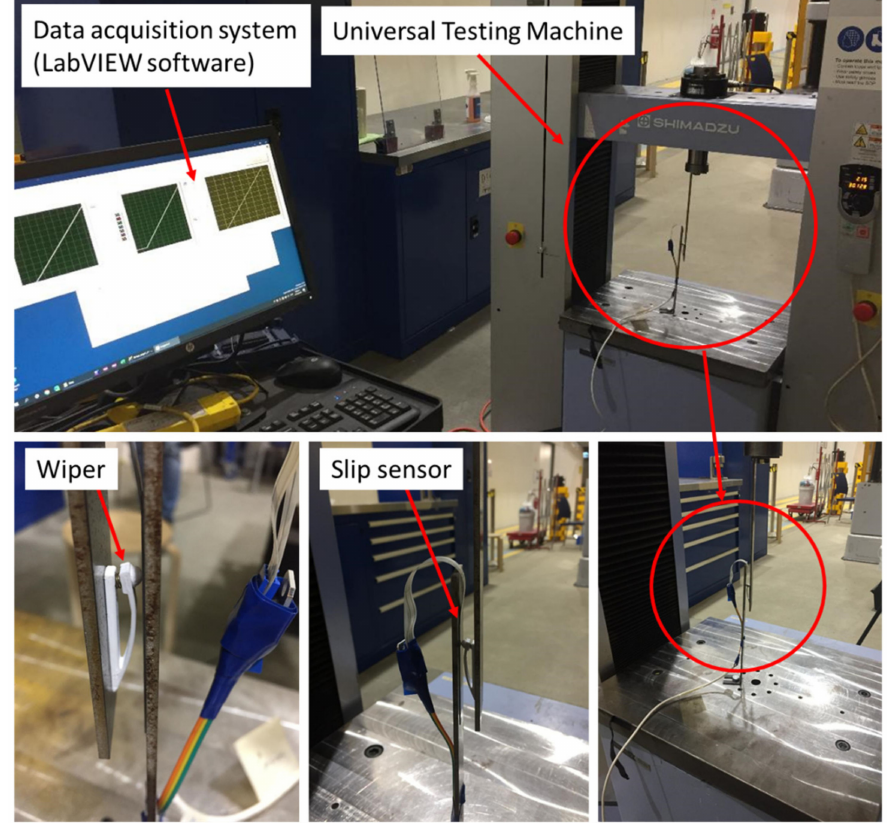
Figure 3. Slip-sensor calibration